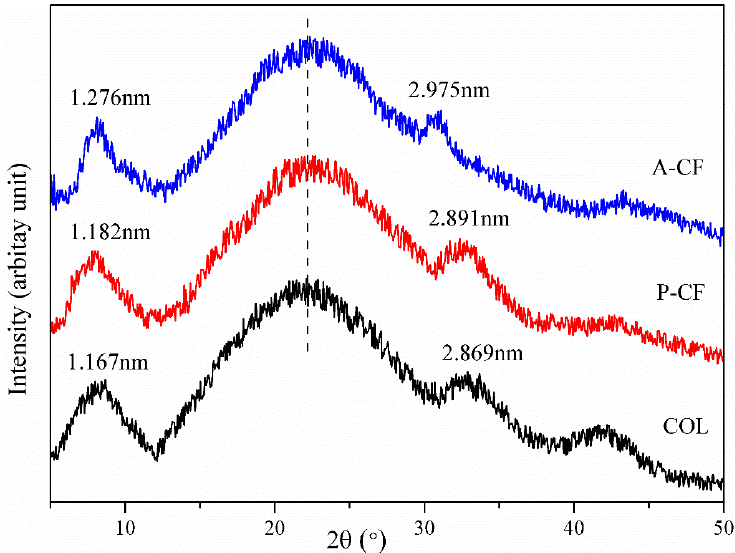
Materials 2020 , 13 , 358 Figure 5. X-ray diffraction patterns of A-CF, P-CF and COL. Figure 5. X-ray di ff raction patterns of A-CF, P-CF and COL.